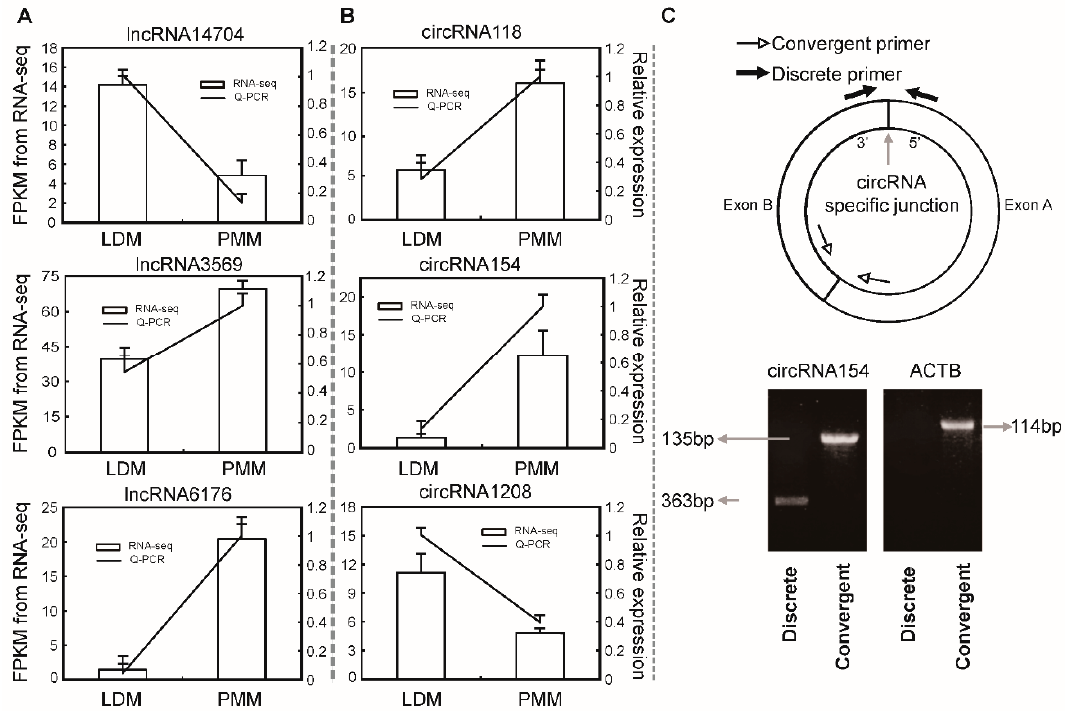
Figure 9. Using qPCR to validate RNA-seq data. ( A ) RNA-seq and q-PCR data of expression levels of 3 randomly selected lncRNAs, n = 3. ( B ) RNA-seq and q-PCR data of expression levels of 3 randomly selected circRNAs, n = 3. ( C ) The illustration of qPCR primers for identifying circRNAs, n = 3.